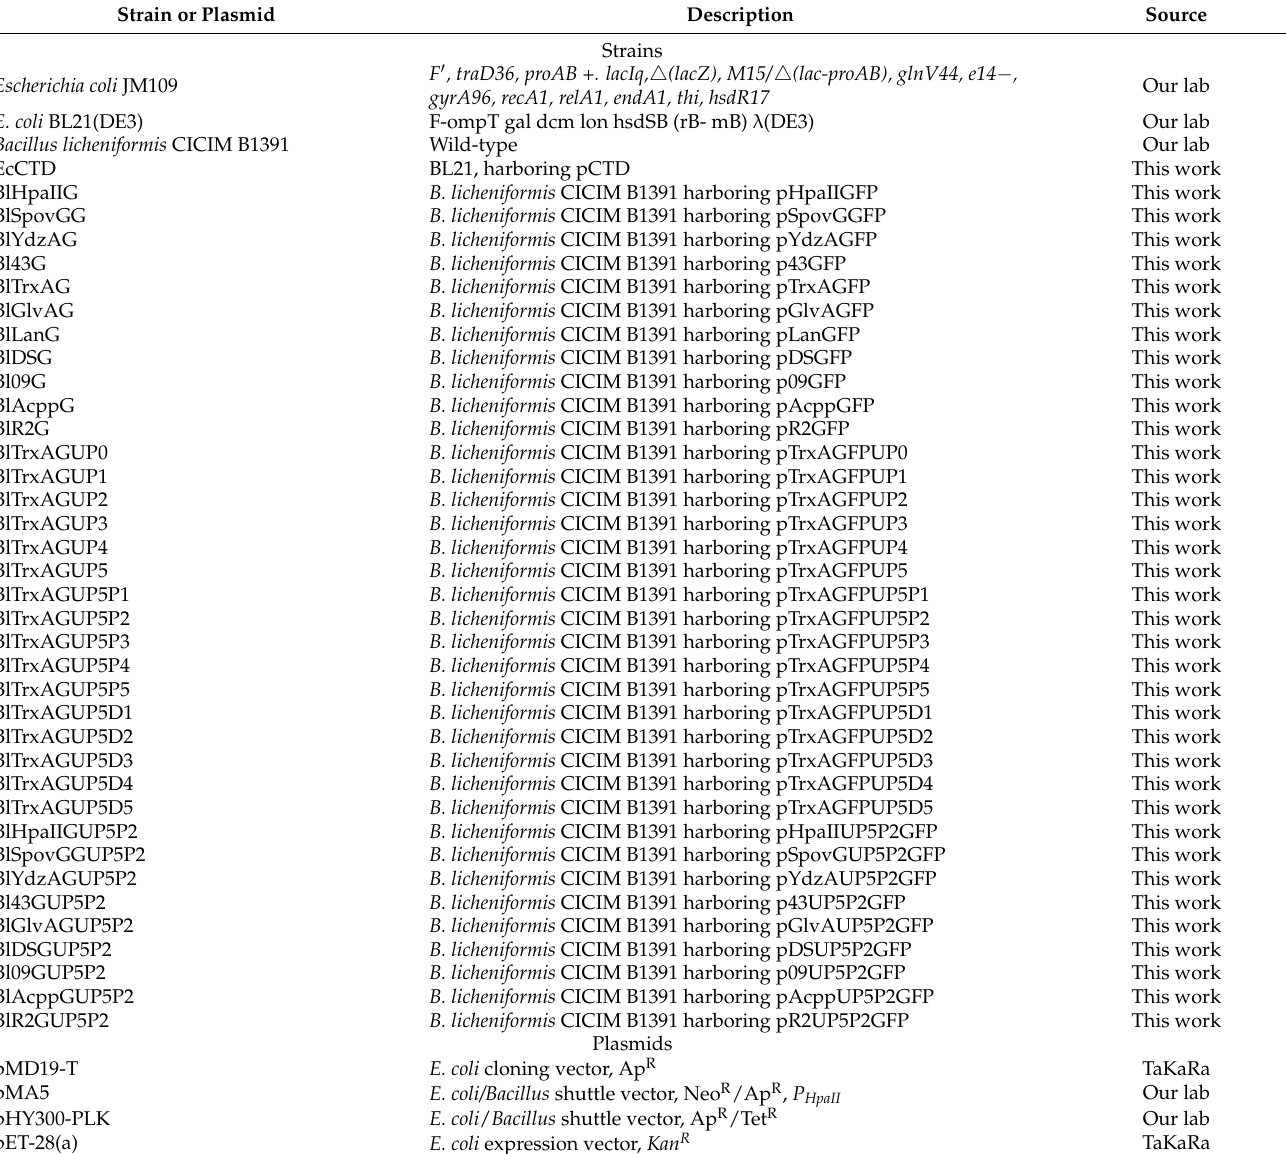
Table 2. Bacterial strains and plasmids used in this